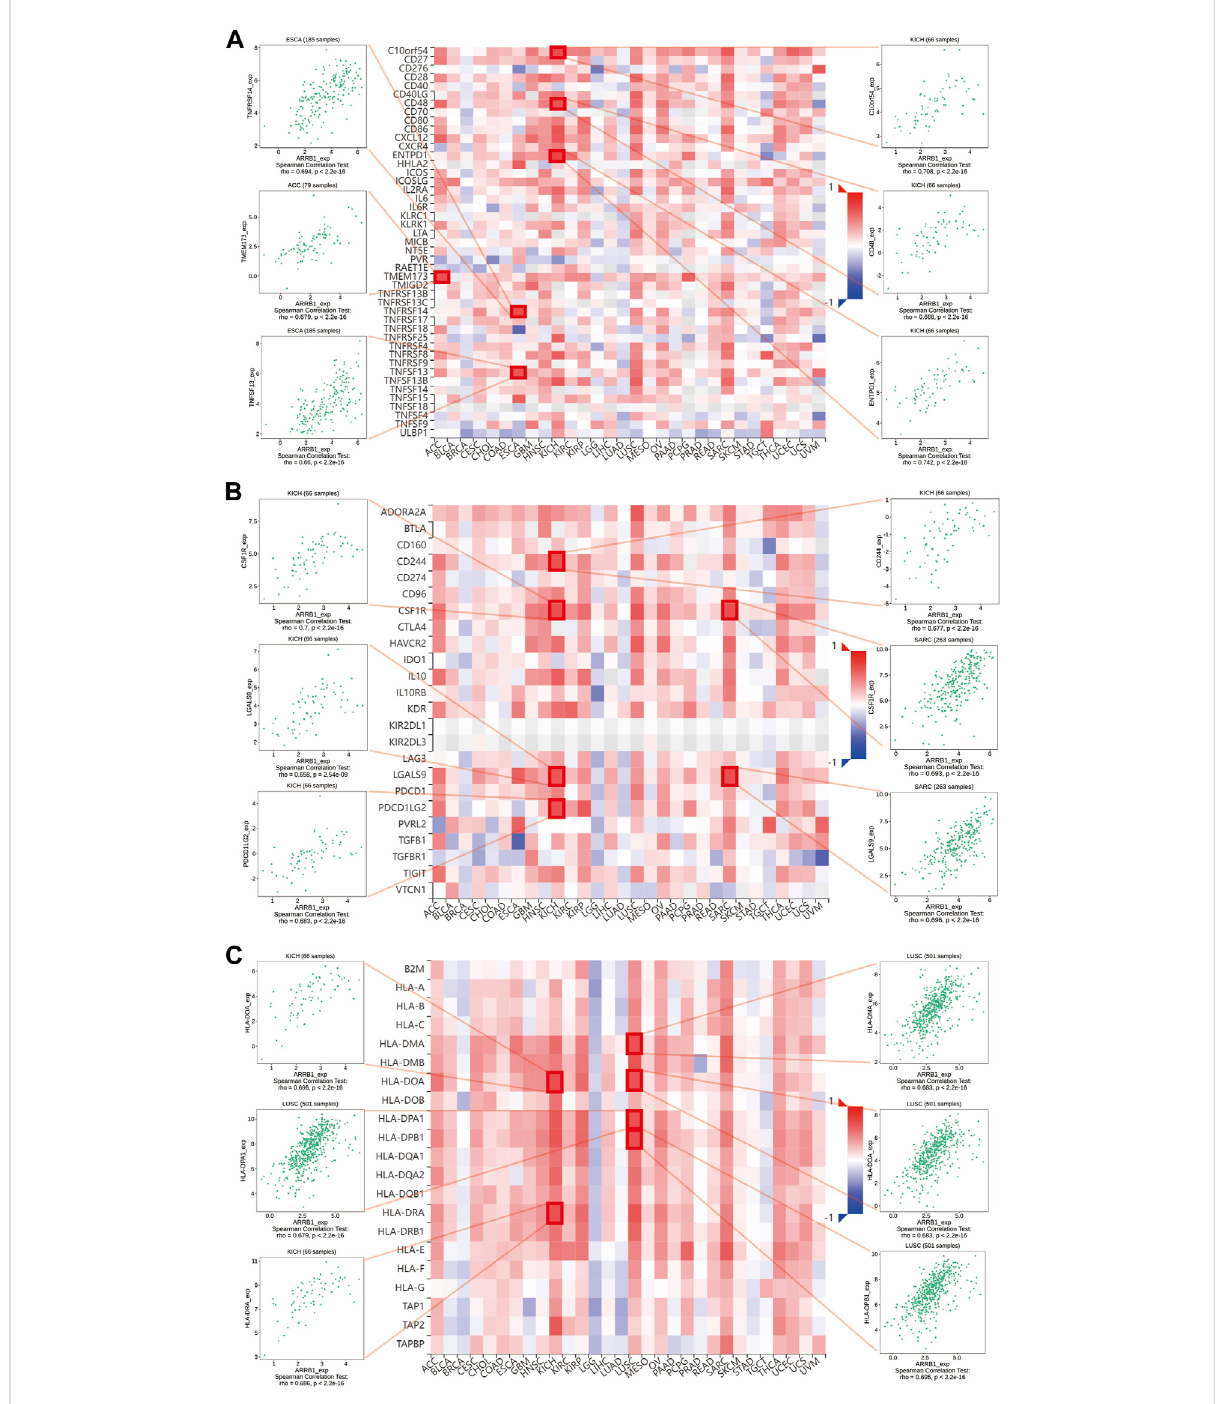
FIGURE 6 Association of ARRB1 with three kinds of immunomodulators across human cancers. (A) Association of ARRB1 expression with immunostimulators. (B) Association of immunoinhibitors with ARRB1 expression. (C) Correlation between ARRB1 expression and MHC molecules. Red color denotes positive correlation, while blue color represents negative correlation. Dot plots are used to show the top 6 strongest associations for each